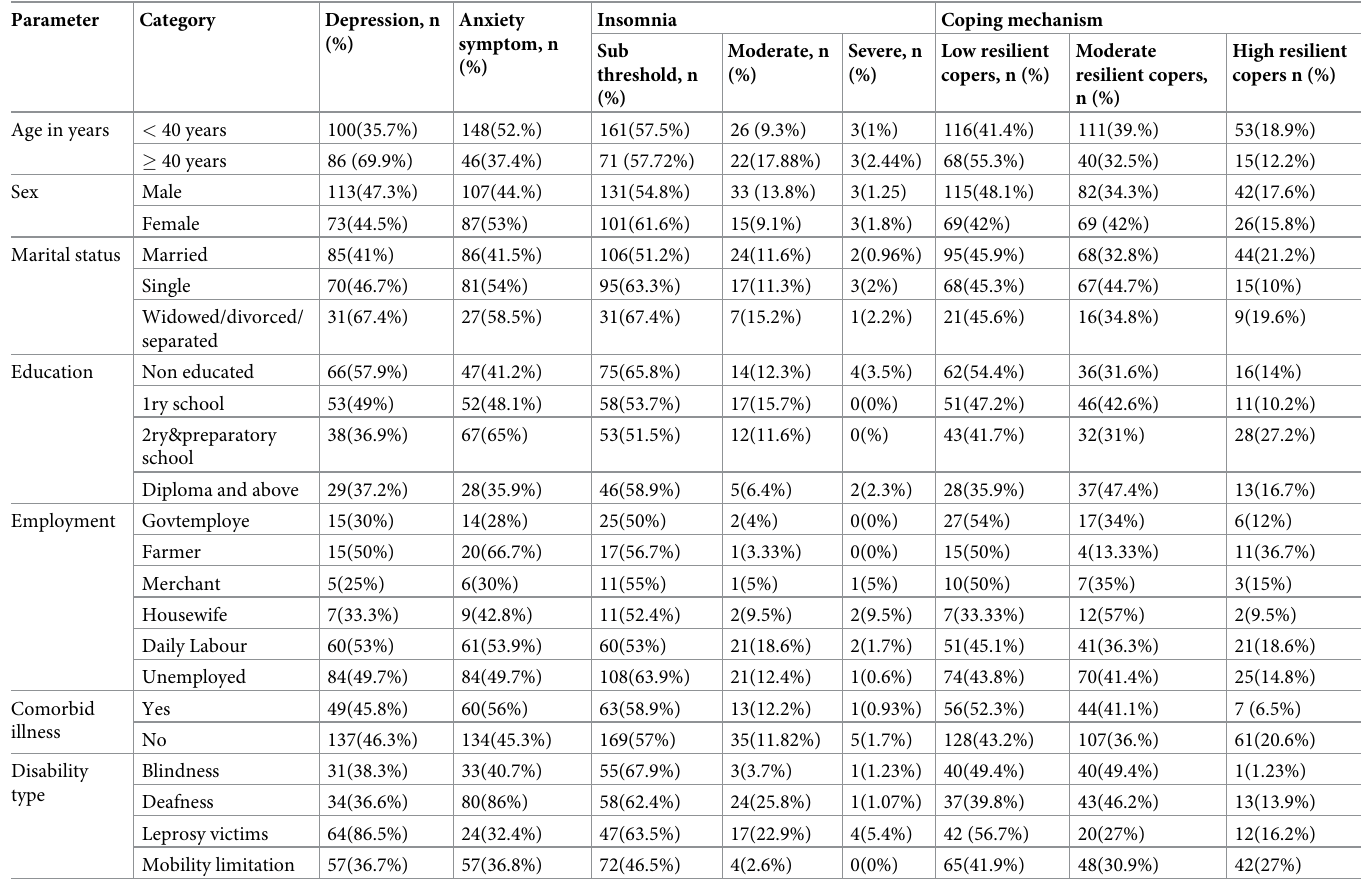
Table 3. Prevalence of depression, anxiety, insomnia and coping by different